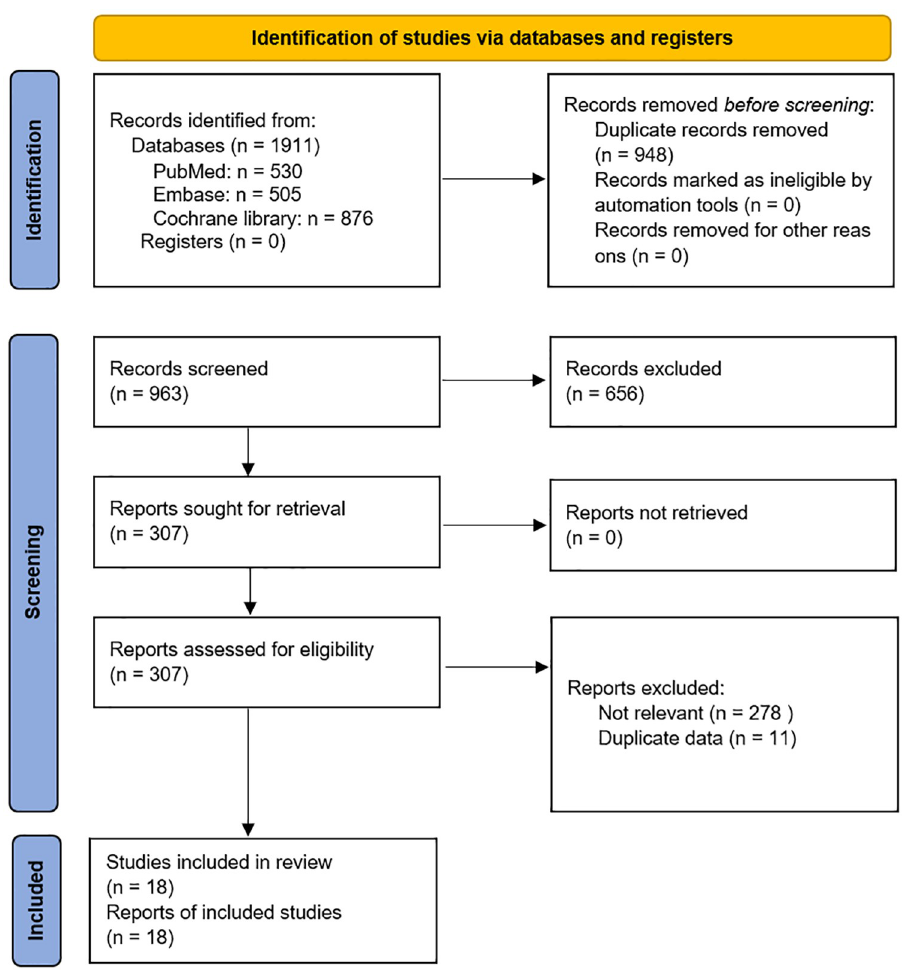
Fig 1. PRISMA diagram of the process for selection of relevant